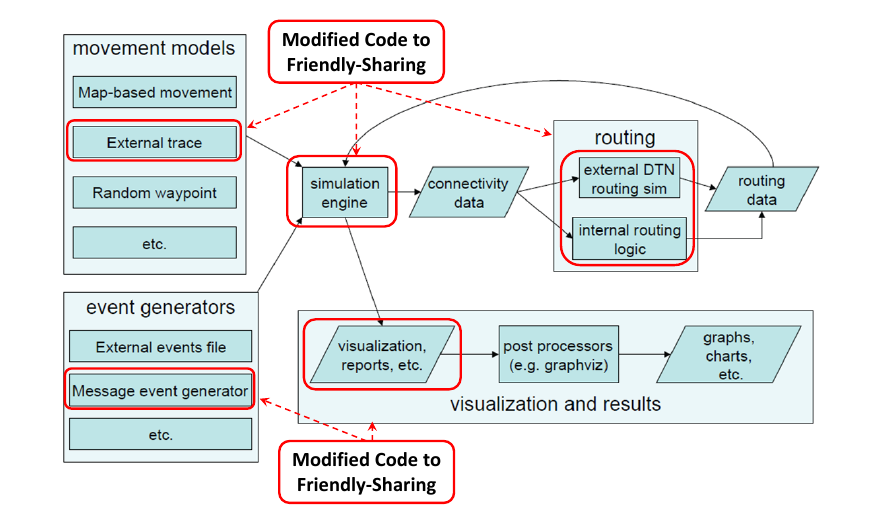
Figure 4. Modifications to the ONE simulator code (original figure from